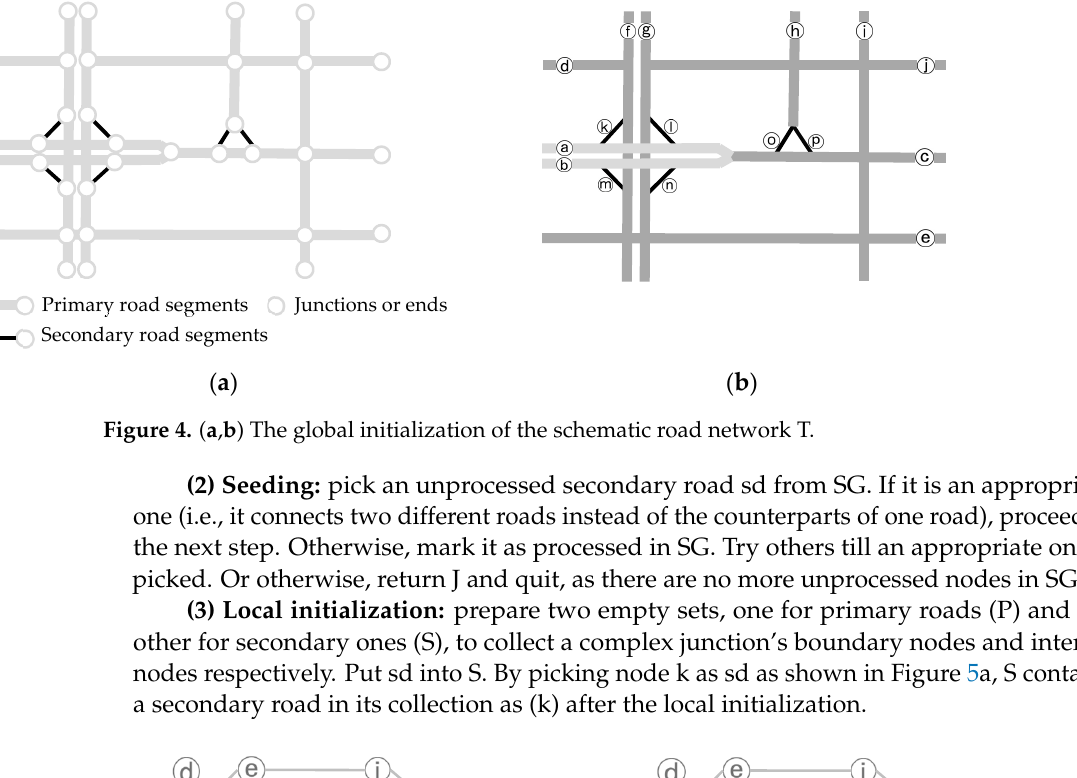
Figure 4. ( a , b ) The global initialization of the schematic road network T.